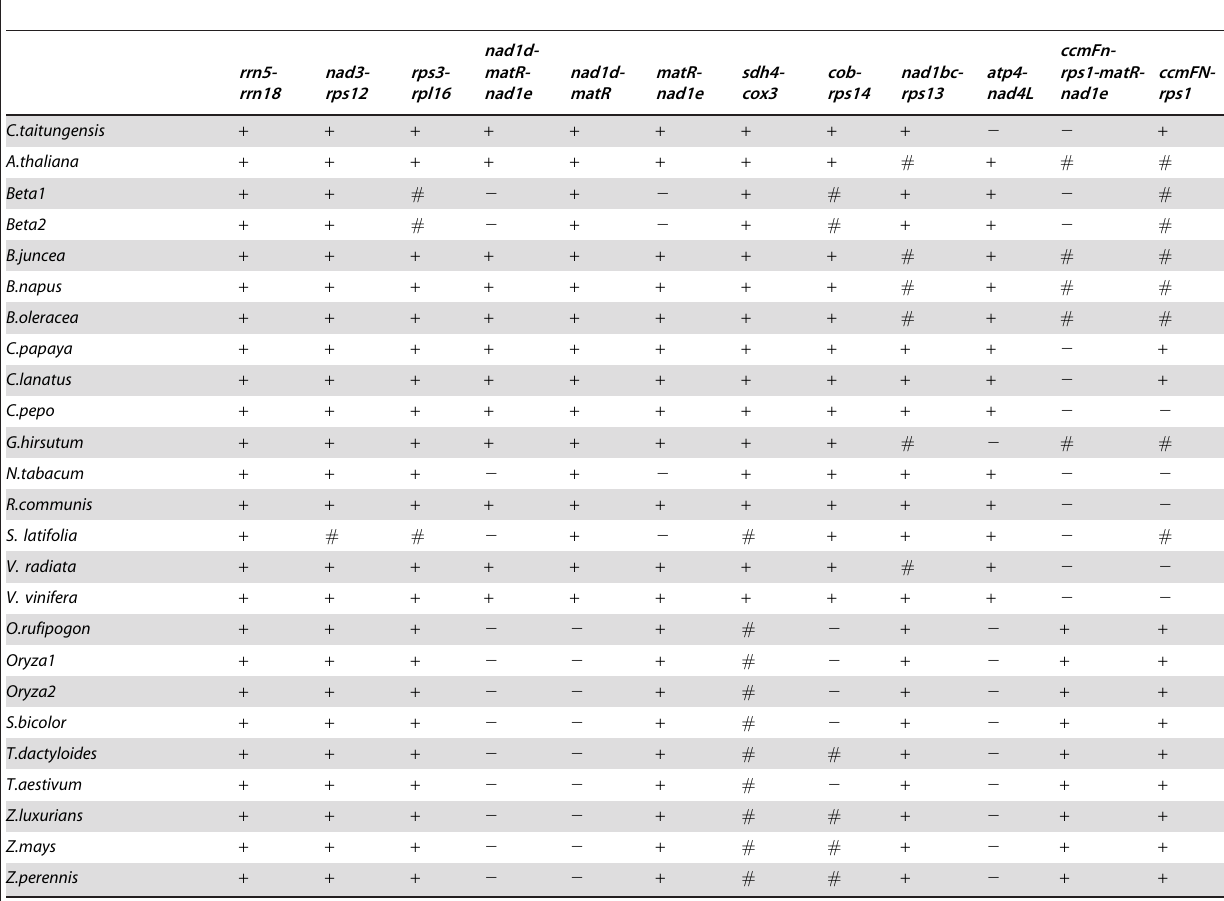
Table 6. Distribution of closely linked clusters in Gossypium hirsutum and other plant mt